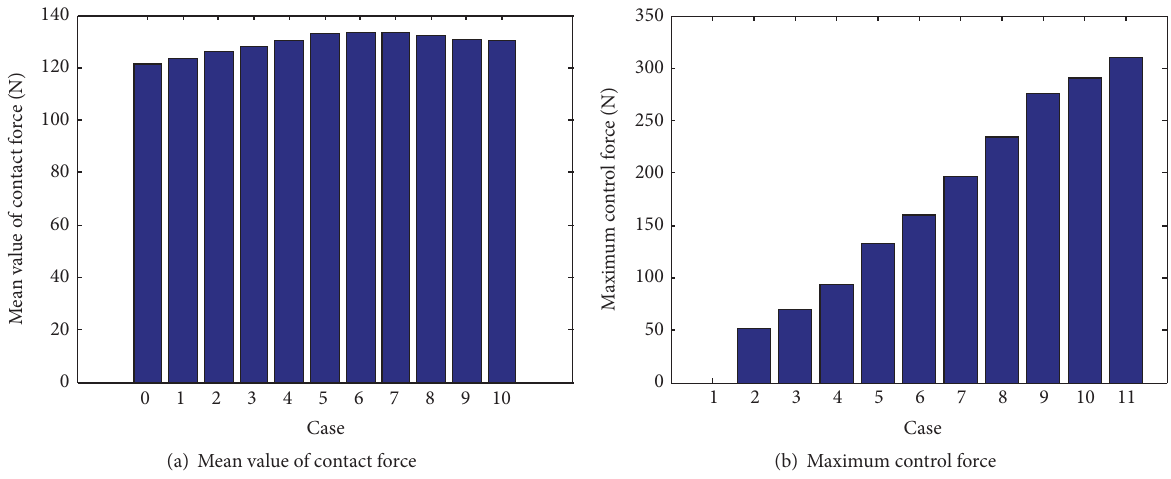
Figure 20: The results of mean value of contact force and maximum control